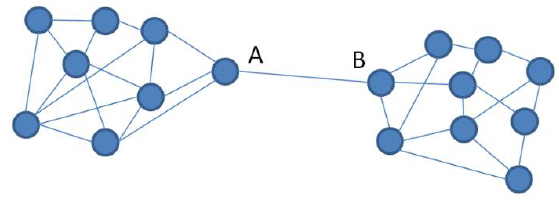
Figure 5. Betweenness Centrality Network Graph.